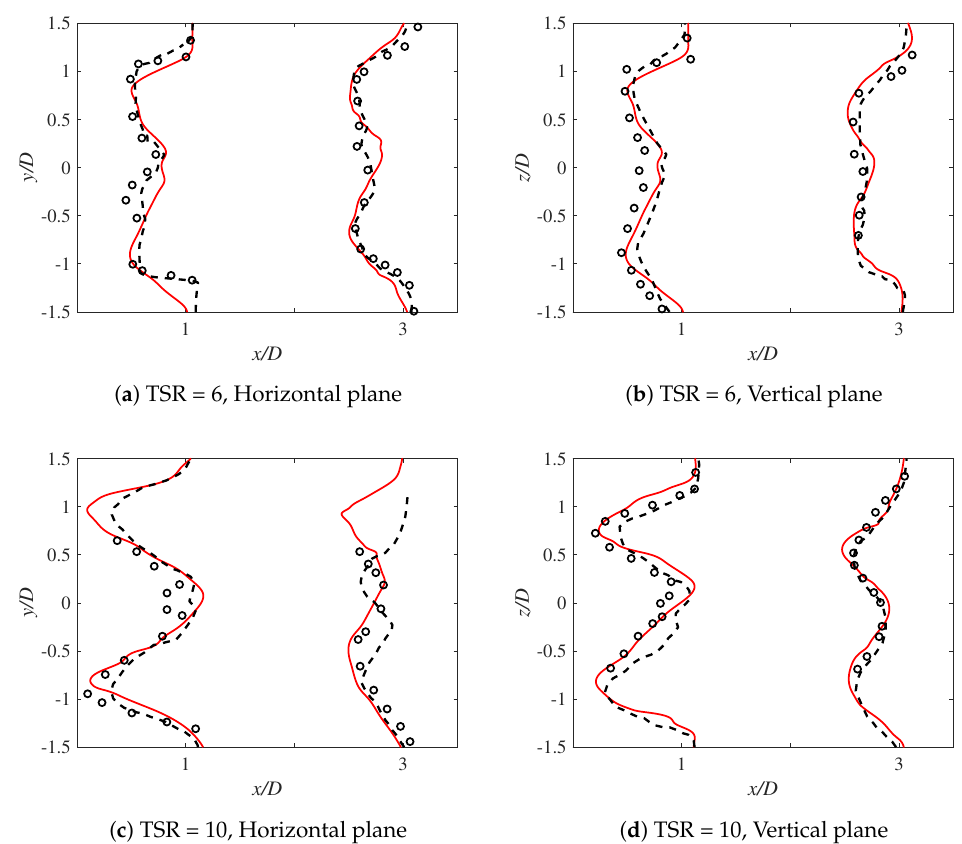
Figure 13. HAWT-S826: Comparison of the velocity deficit using Case-V (complete turbine including the nacelle and tower), at successive locations of x / D of 1 and x / D of 3 in the wake region and TSR values of 6 ( a , b ) and 10 ( c , d ). Velocity profiles were predicted by MRF (solid lines) and SMI (dotted lines) with the experimental results (circles) taken from [37]. Successive profiles were offset for better clarity.